Question: Write a caption explaining this figure to a reader.
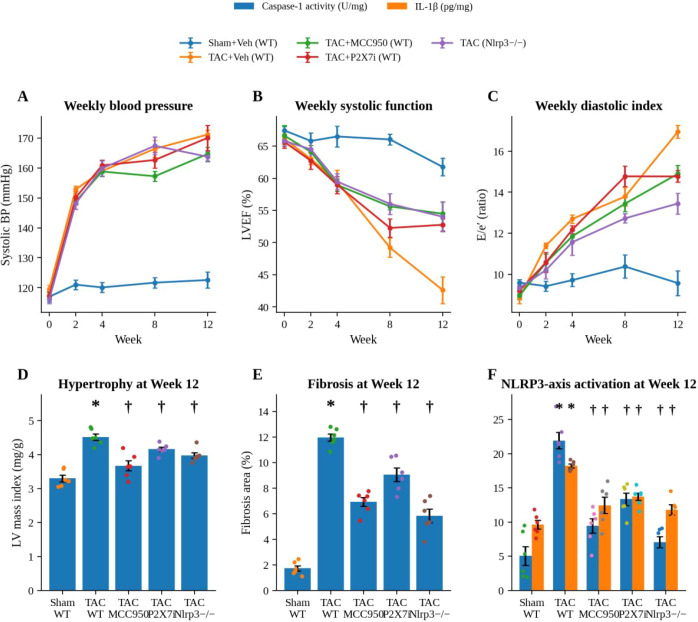
Answer: Validation of transverse aortic constriction (TAC)-induced pressure overload and progressive cardiac remodeling. (A) Weekly systolic blood pressure measured by tail cuff. (B) Longitudinal change in left ventricular (LV) systolic function [LV ejection fraction (LVEF)]. (C) Time-dependent change in diastolic load assessed by E/e′. (D) LV hypertrophy at week 12 (LV mass index). (E) Myocardial fibrosis at week 12. (F) Representative inflammasome-axis activation readouts at week 12, including caspase-1 activity and IL-1β. Data are shown according to the prespecified grouping and sampling framework. Statistical comparisons were performed as described in the Methods. *P < 0.05 and **P < 0.01 vs Sham+Vehicle (WT); †P < 0.05 and ††P < 0.01 vs TAC+Vehicle (WT), unless otherwise indicated.